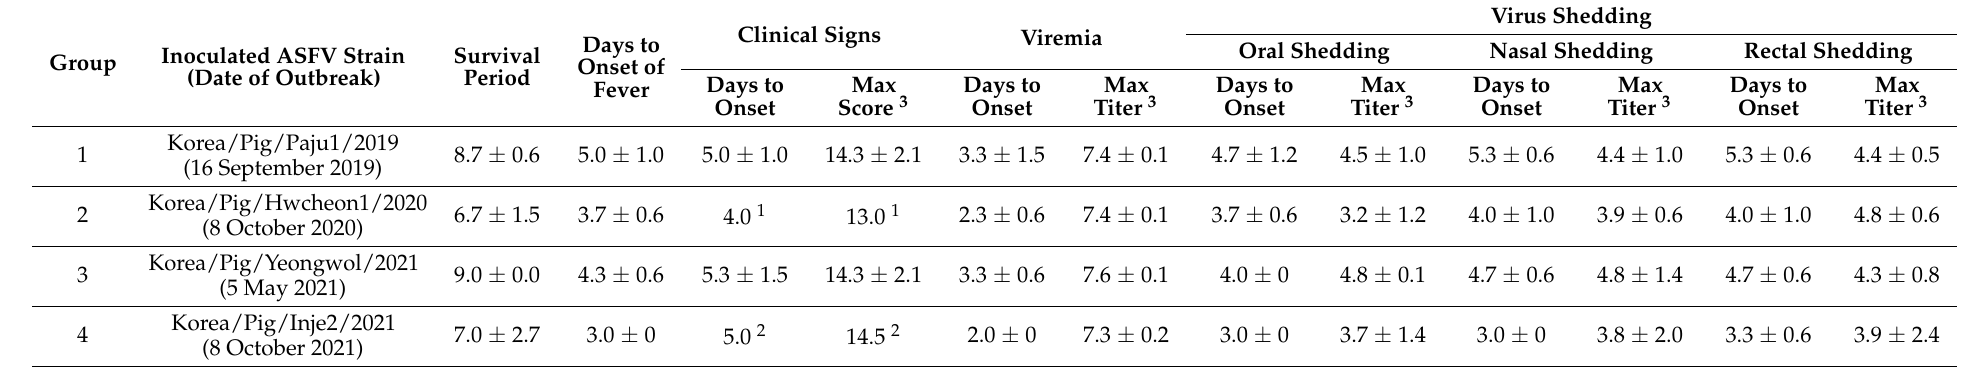
Table 1. Clinical characteristics and virological parameters of pigs infected with four ASFV isolates from domestic pig farms in South Korea from 2019 to 2020. All data are shown as average ± standard deviation.